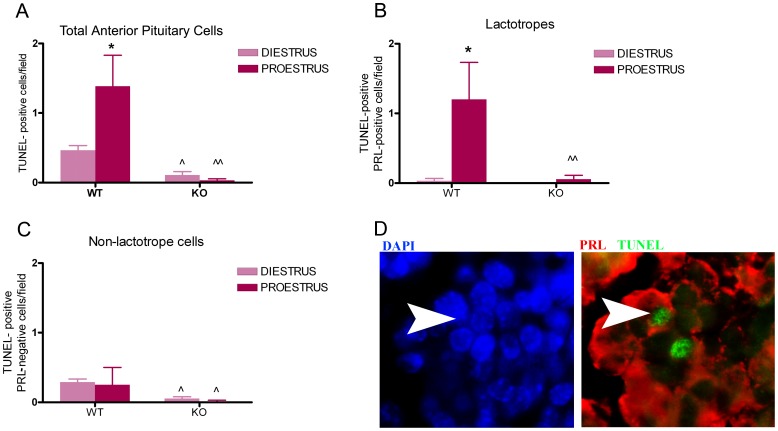
Apoptosis in lactotropes but not in non-lactotrope cells varies during the estrous cycle and decreases in PRLRKO mice.Wild type and PRLRKO mice (6–10 animals per group) were euthanized at proestrus or diestrus. Apoptosis was determined by TUNEL assay in tissue sections. A: Each column represents the media ± SEM of TUNEL-positive cells/field. *p<0.05 vs. diestrus WT, ∧p<0.01 vs. diestrus WT, ∧∧p<0.01 vs. proestrus WT. Two-way ANOVA, followed by Tukey's test. B: Each column represents the media ± SEM of apoptotic lactotropes (TUNEL-positive PRL-positive cells/field). *p<0.05 vs. diestrus, ∧∧p<0.01 vs. proestrus WT. Two-way ANOVA, followed by Tukey's test. C: Each column represents the media ± SEM of apoptotic non-lactotrope cells (TUNEL-positive PRL-negative cells/field). ∧p<0.05 vs. diestrus WT or proestrus WT. Two-way ANOVA, followed by Tukey's test. D: Representative microphotographs of anterior pituitaries from WT mice euthanized at proestrus. Arrow heads indicate a TUNEL-positive lactotrope.